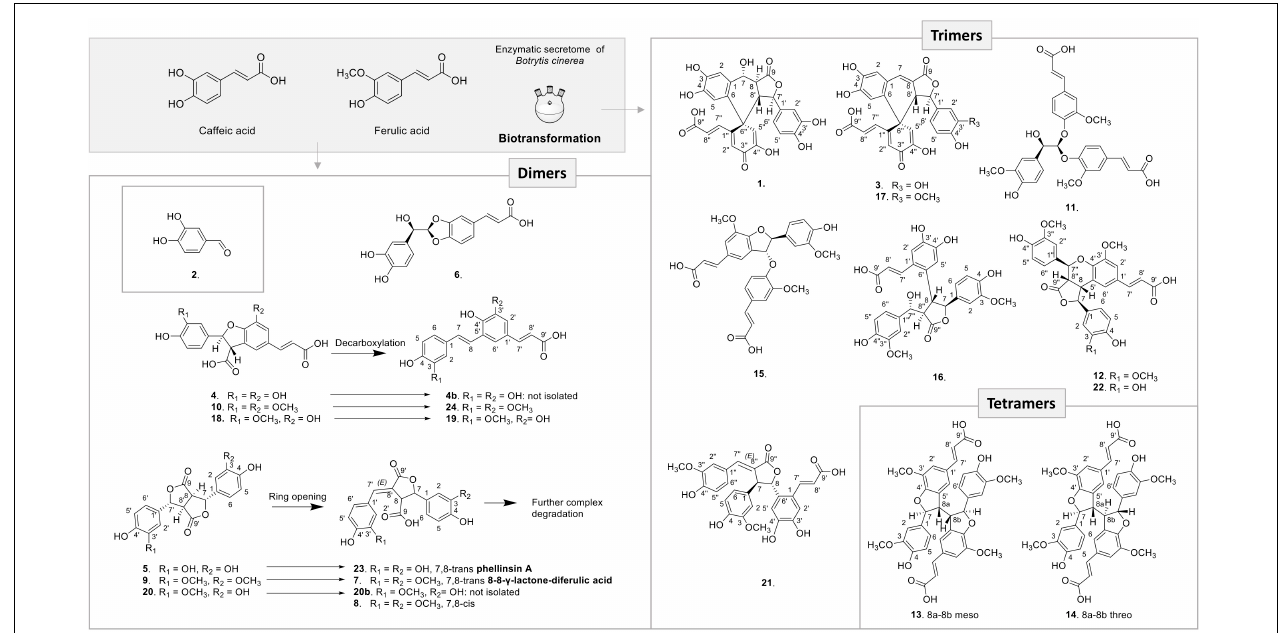
FIGURE 4 | Compounds generated by the three biotransformation reactions with caffeic acid, ferulic acid, and mixture of both acids with the enzymatic secretome of B.